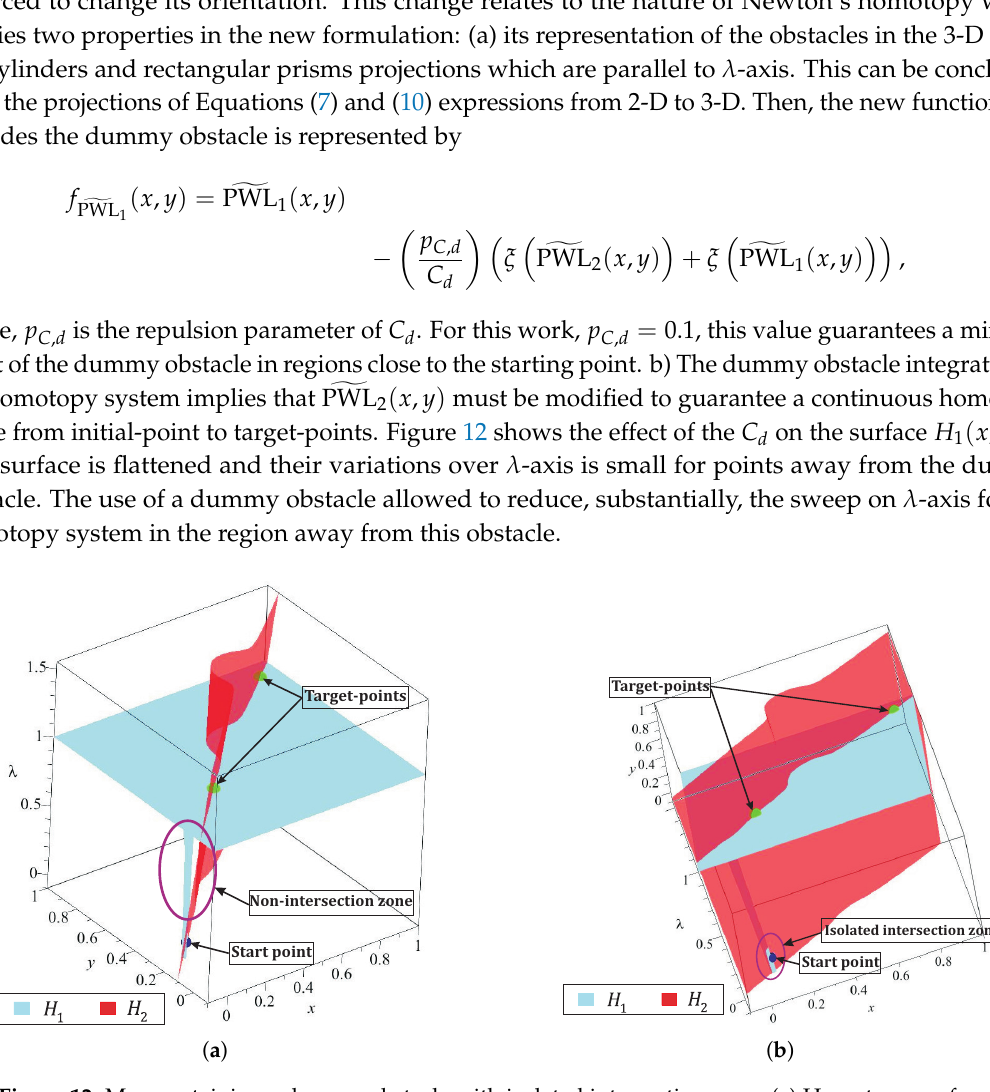
Figure 12. Map containing a dummy obstacle with isolated intersection zone. ( a ) Homotopy surfaces representation (View 1). ( b )Homotopy surfaces representation (View